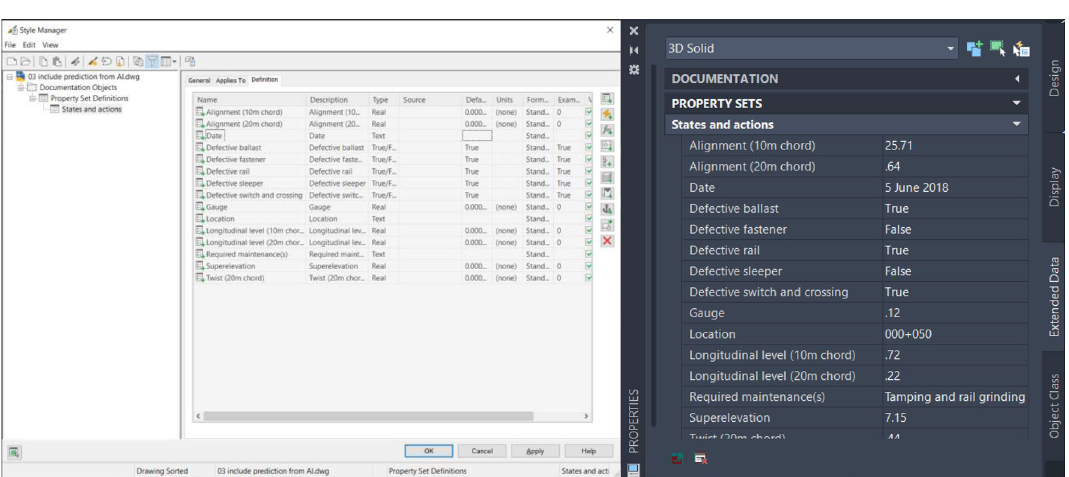
Figure 14. States and actions defined in the digital twin